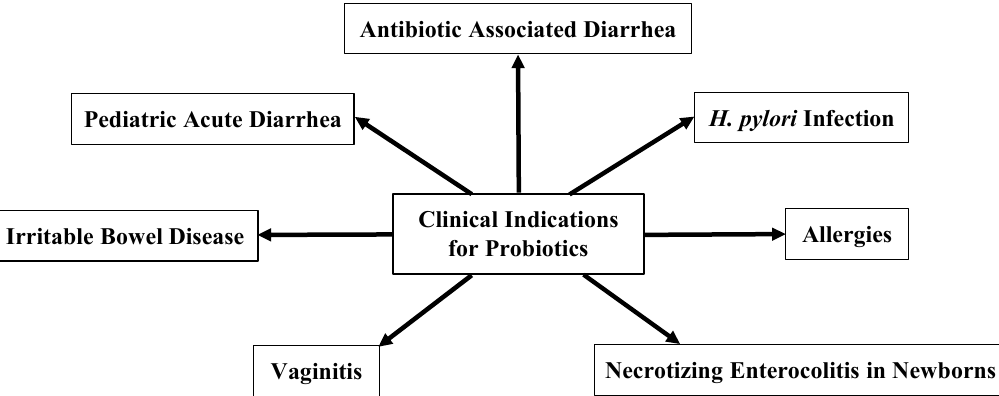
Figure 1. Clinical indications for probiotics.